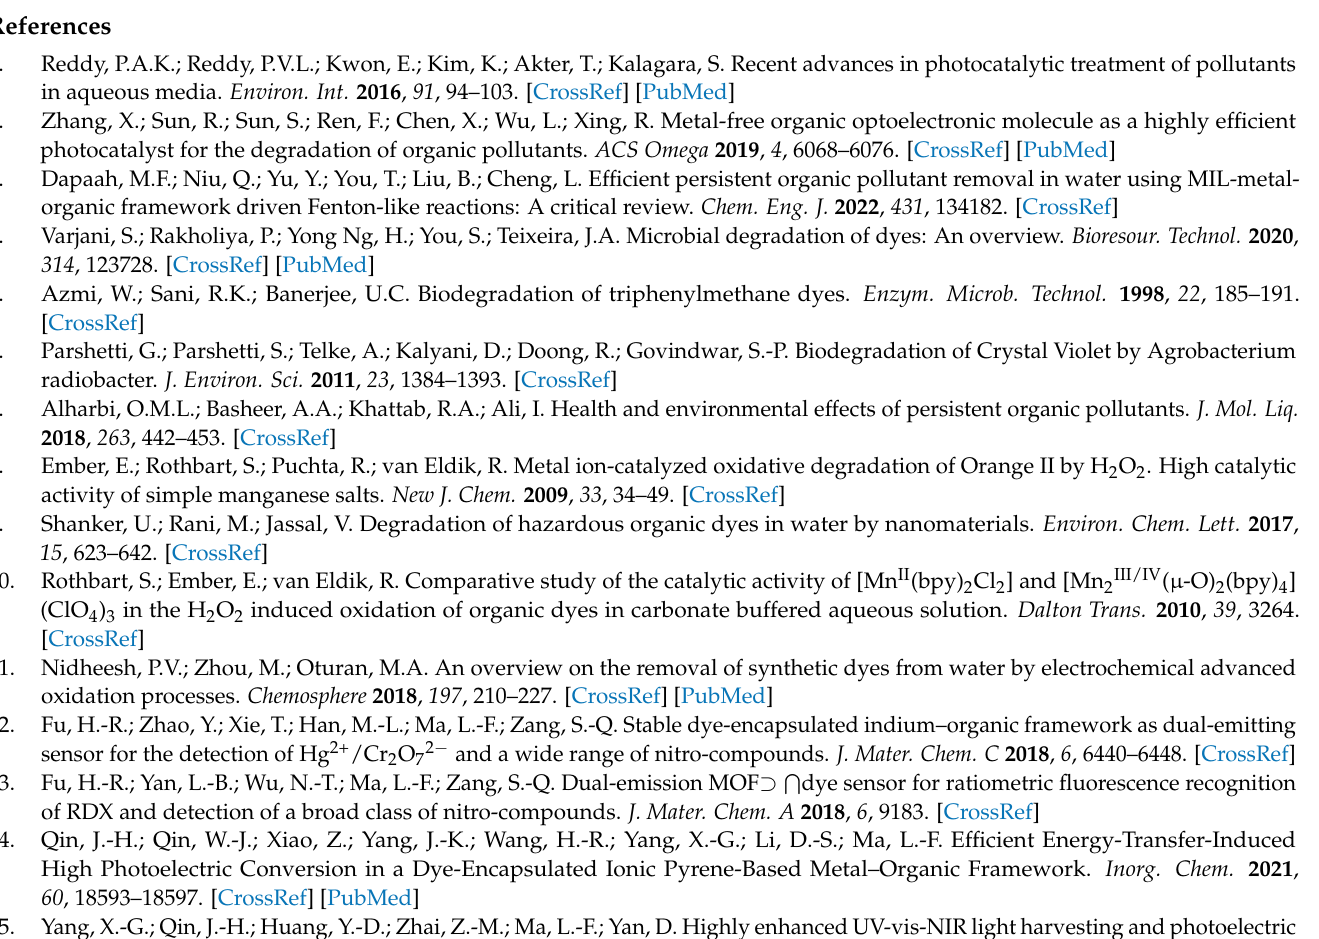
0.5 h; Figure S4: UV − vis spectral change observed in the degradation of gentian violet by various concentrations of PhIO. Conditions: gentian violet 0.05 mM; [Fe III (TCPP)] 0.005 mM; PhIO 0, 1, 2, 3, 4, 5 equiv; solvent MeOH; 303 K; reaction time 1 h; Figure S5: UV − vis spectral change observed in the degradation of gentian violet by various concentrations of PhIO. Conditions: gentian violet 0.05 mM; [Fe III (TCPP)] 0.005 mM; PhIO 0, 1, 2, 3, 4, 5 equiv; solvent MeOH; 303 K; reaction time 1.5 h; Figure S6: UV − vis spectral change observed in the degradation of gentian violet by various concentrations of PhIO. Conditions: gentian violet 0.05 mM; [Fe III (TCPP)] 0.005 mM; PhIO 0, 1, 2, 3, 4, 5 equiv; solvent MeOH; 303 K; reaction time 2 h; Figure S7: GC-MS analysis of the degradation products of crystal violet degraded by the [Fe III (TCPP)]/PhIO system after color removal. (a) Gas chromatogram; (b) mass spectra for the peak with RT value of 5.028